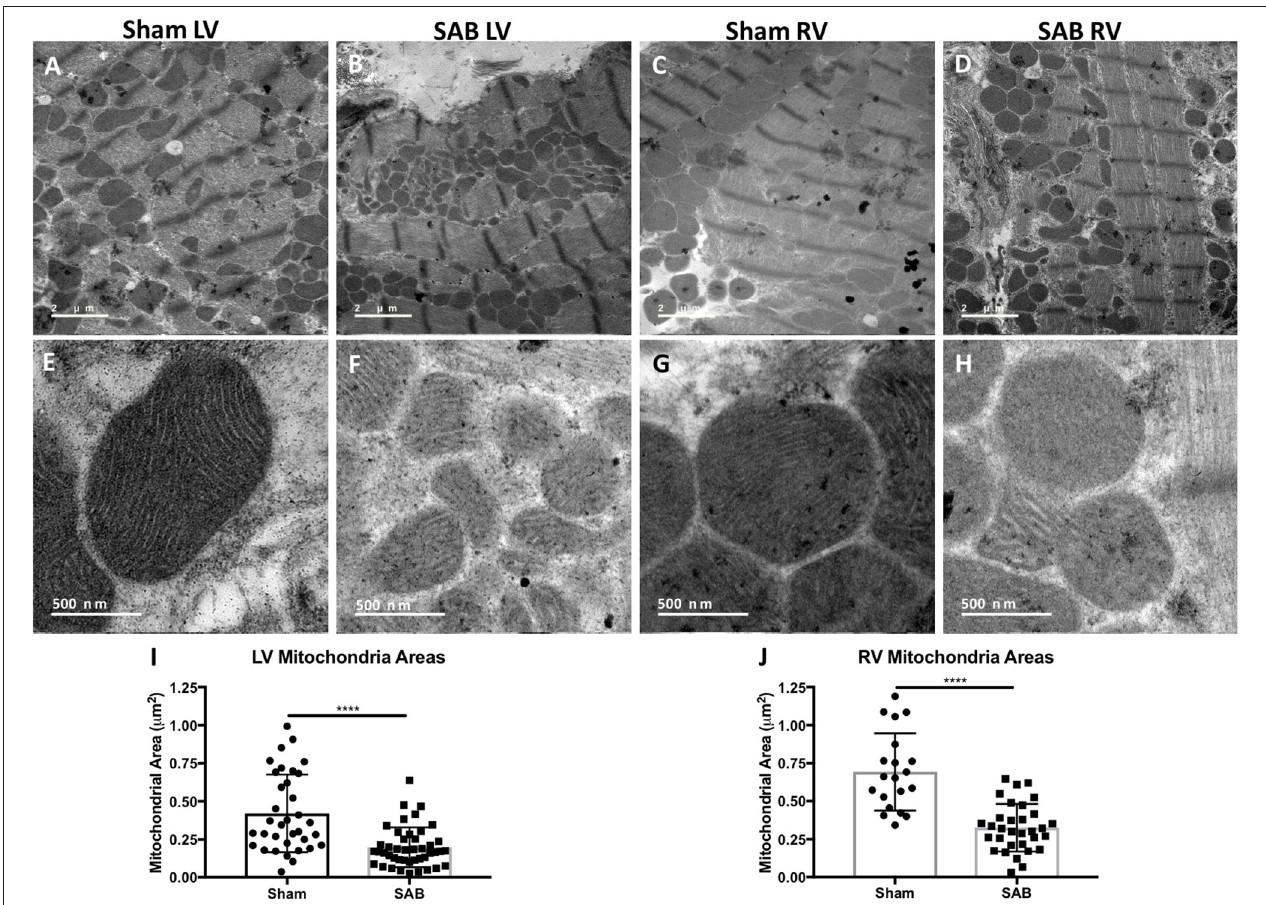
FIGURE 5 | Representative transmission electron microscopy (TEM) images showing reduced average mitochondria area in the left ventricle (LV) and right ventricle (RV) at 2 different magnifications. (A) Low magnification of sham LV, (B) supra-coronary aortic banding (SAB) LV, (C) sham RV, and (D) SAB LV. High magnification showing mitochondrial ultra-sturcture in (E) sham LV, (F) SAB LV, (G) sham RV, and (H) SAB RV. (I) Average LV mitochondrial area, and (J) average RV mitochondrial area. Each dot represents a single